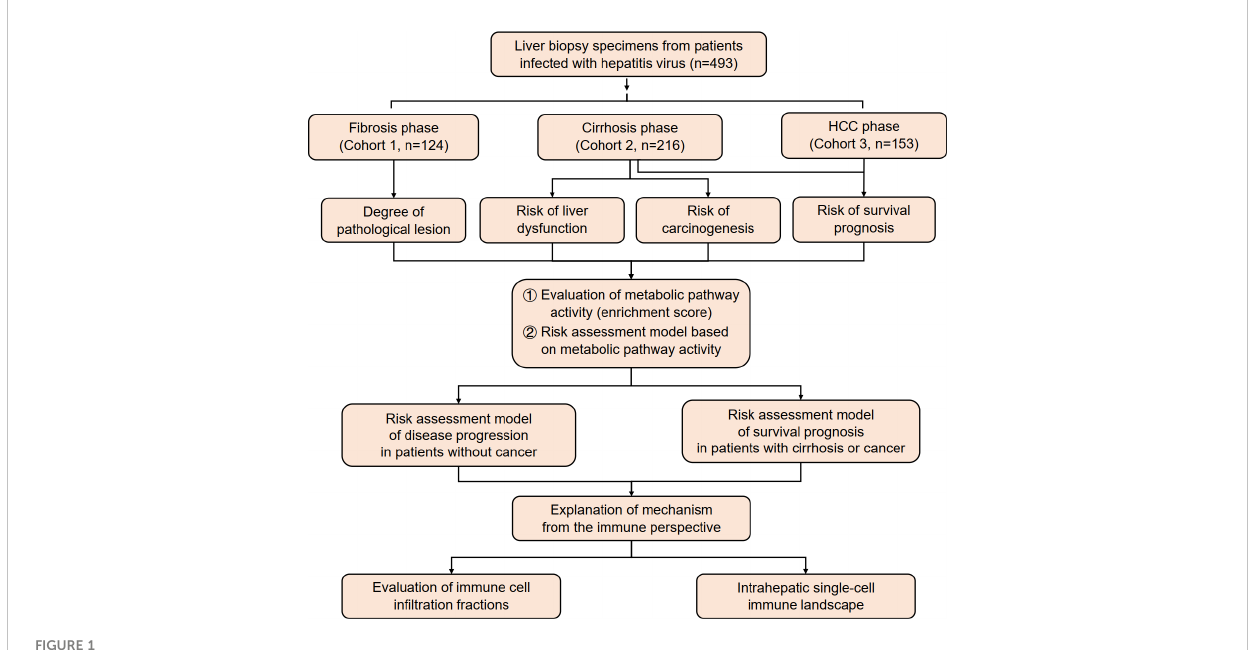
FIGURE 1 An overview of the study ’ s design and